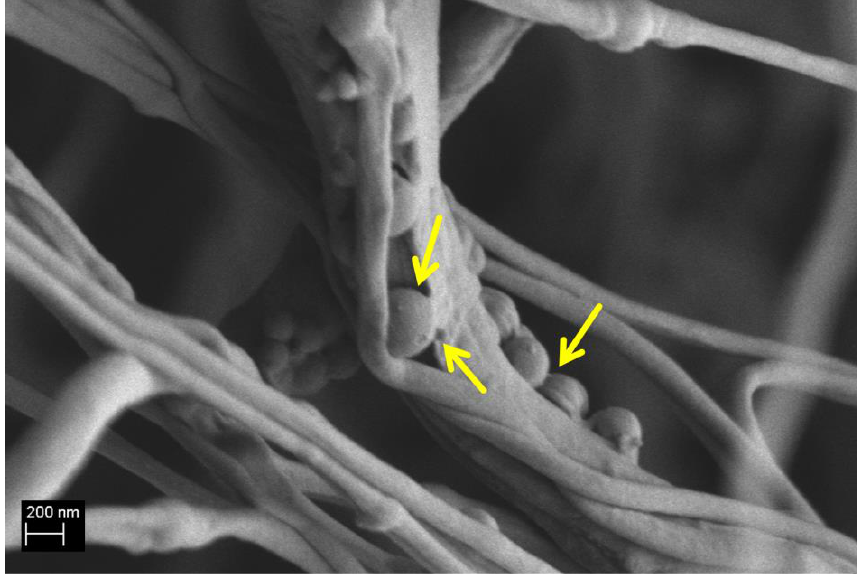
Figure 7. SEM micrograph of composite PCL_Ca_MCM-41 electrospun fibers after the tensile test, indicating lack of strong adhesion at the particle-PCL interface (arrows).